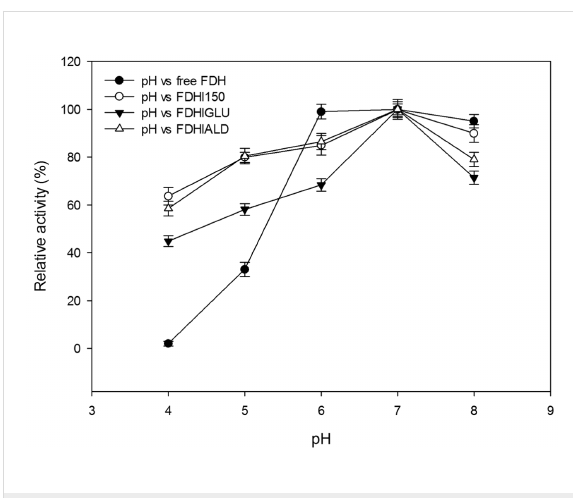
Figure 2: The effect of pH on the activities of free and immobilized FDH preparations. The FDH activity at pH 7.0 was taken as 100% for the each preparation. The experiments were run in